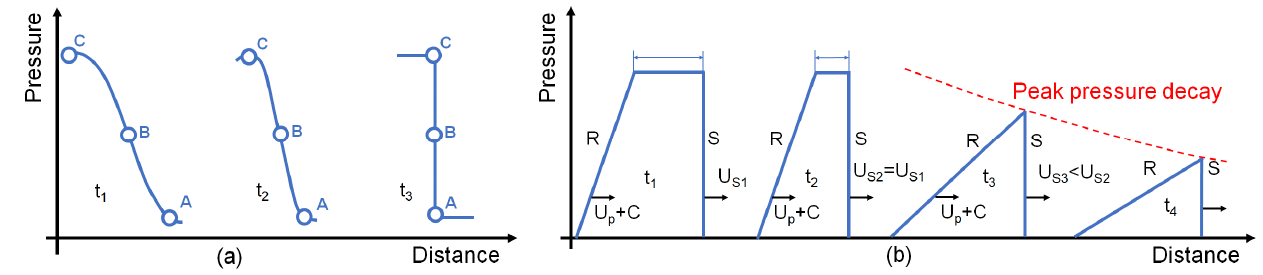
Figure 1. Graphical representation of: ( a ) the shockwave formation; ( b ) the propagation and attenuation of the shockwave, where S is the shock front and R is the release part of the shock, U S is the shock front velocity, U P is the particle velocity and C is the sound velocity at a particular pressure.